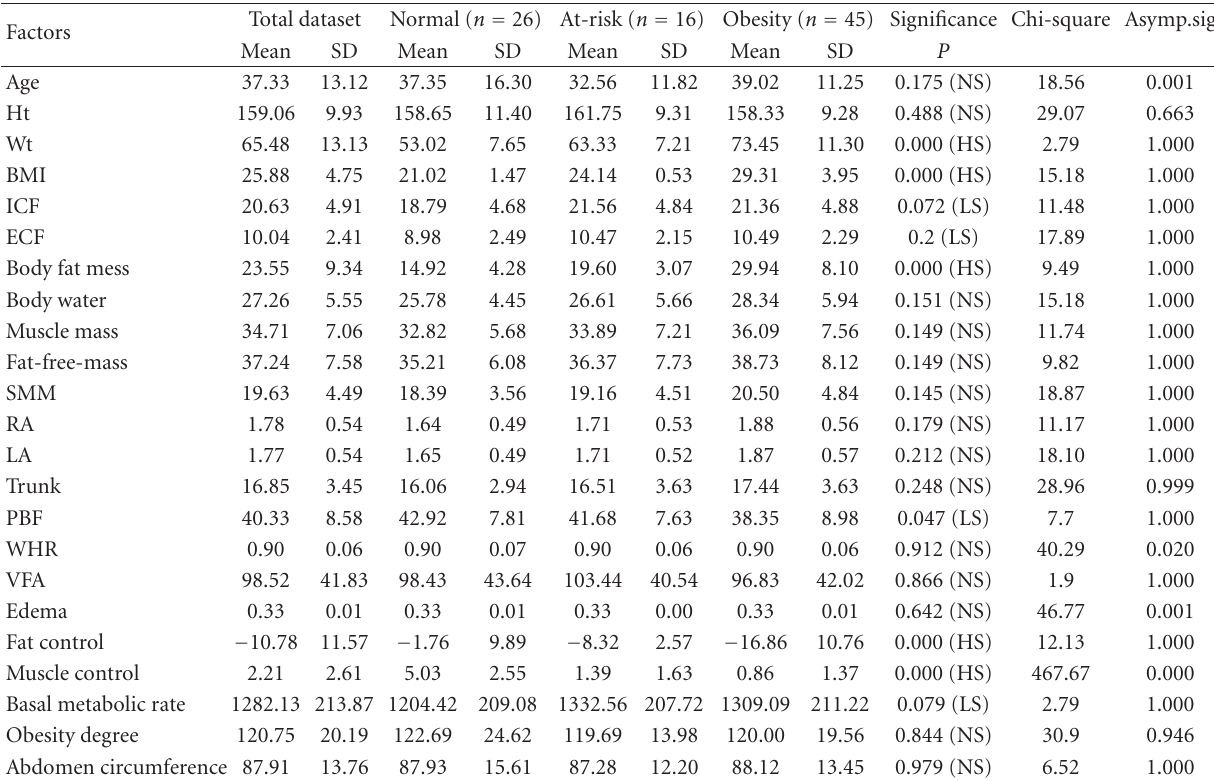
(a) Analysis of anthropometric and body composition characteristics between groups (normal, at risk, and obese) and